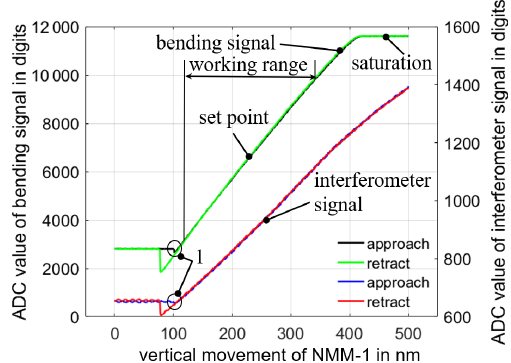
Figure 8. Characteristic curves of the bending signal and the inter- ferometer signal (see also blue and violet arrows/signals in Fig. 6). Note: 1 – contact point.